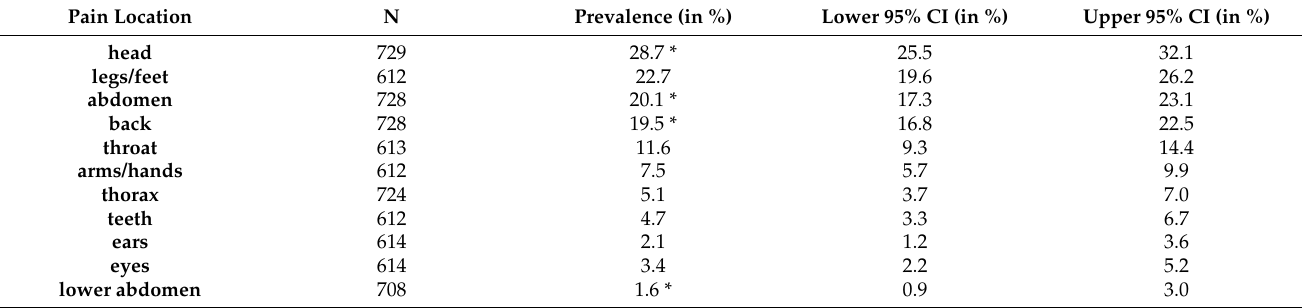
Table 2. Prevalence and 95% CI of recurrent pain for